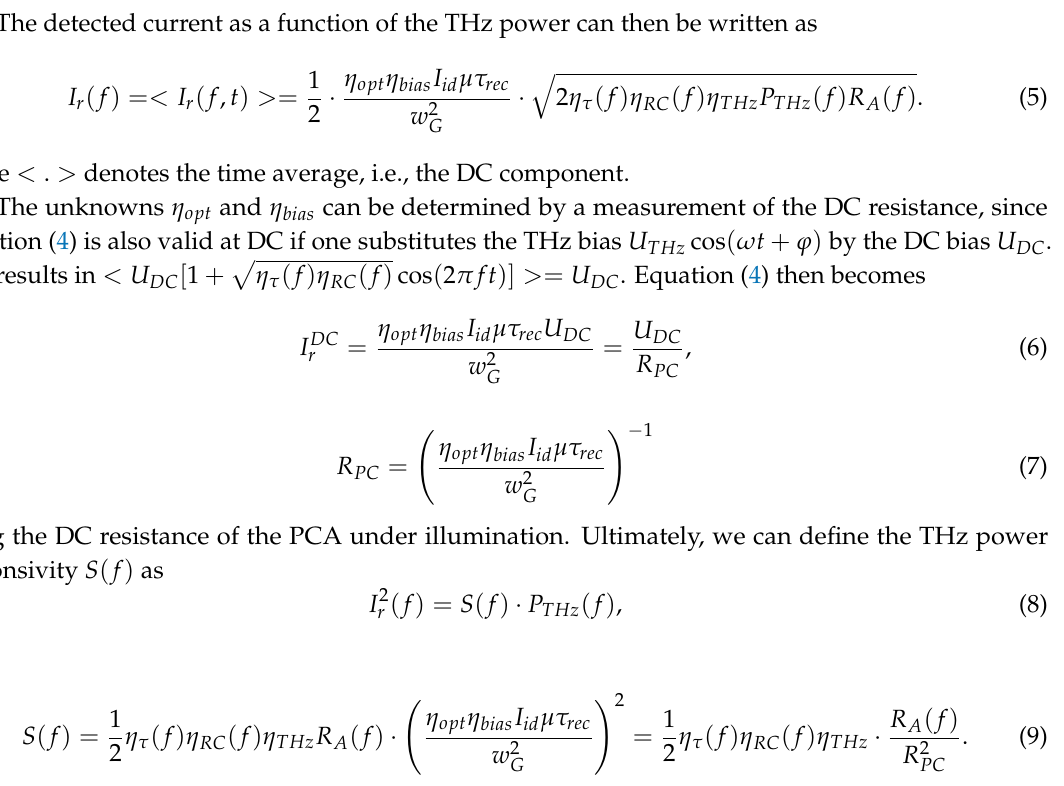
Figure 2. Equivalent circuit of the receiving antenna including the incoming THz wave with power P THz ( f ) , the antenna and the photoconductor. The value of U THz ( f ) is the Thevenin equivalent open-circuit voltage source, as defined in